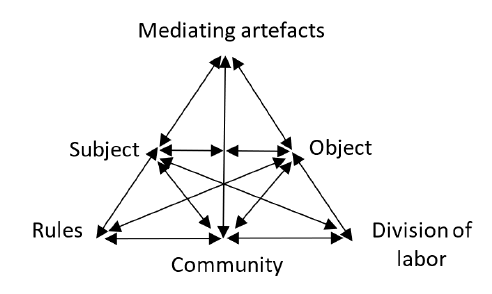
Fig. 1 Engeström’s (1987) third generation AT framework. AT, Activity